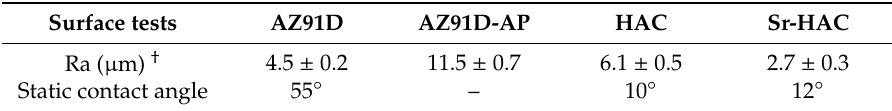
Table 1. The average surface roughness (Ra) and static contact angles of grit-blasted AZ91D, alkaline pre-treated AZ91D-AP, hydrothermal HAC and Sr-HAC